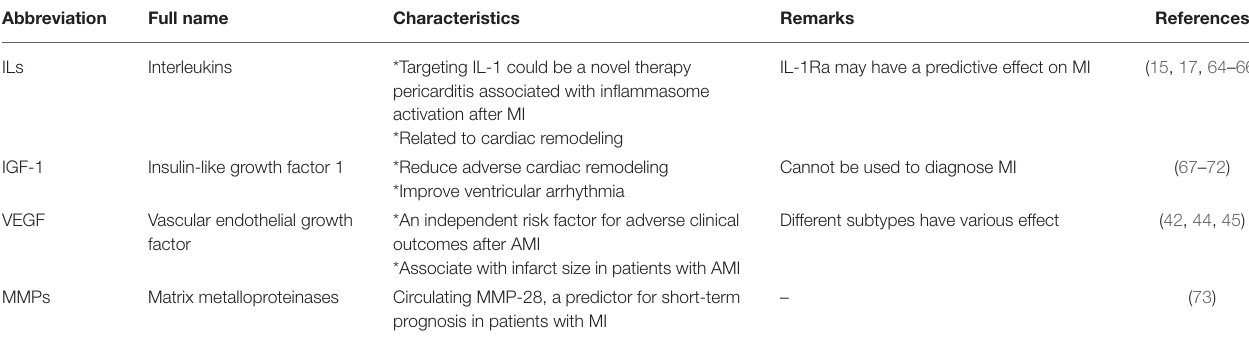
TABLE 3 | Biomarkers induced by MI